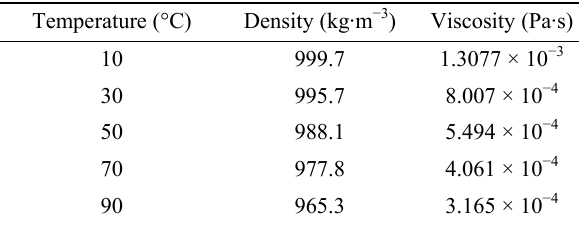
Table 2 Temperature-density-viscosity relationship of water.